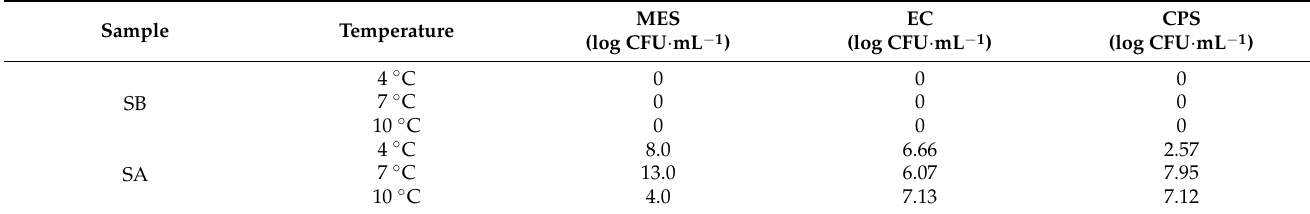
Table 4. Mean population of mesophilic microorganisms (MES), enterobacteria (EC), and coagulase- positive Staphylococcus (CPS) in the pre-chiller water before and after immersion of the carcasses in the tank at different